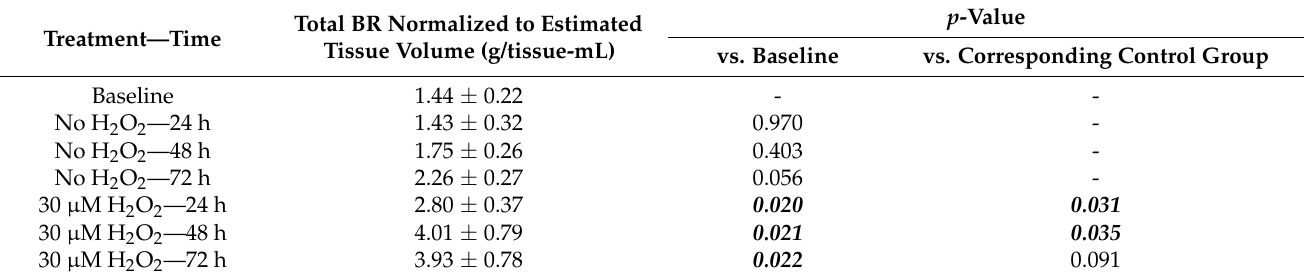
Table 1. Time-course changes in total bilirubin (BR) concentration with and without 30 µ M hydrogen peroxide treatment in MatTek EpiDerm™ 3D human skin-equivalent model. Tissue volume was estimated as 0.0025 mL/tissue based on assumption of 8 mm in diameter, 50 µ m in thickness. Data are mean ± SEM. n = 4/group.